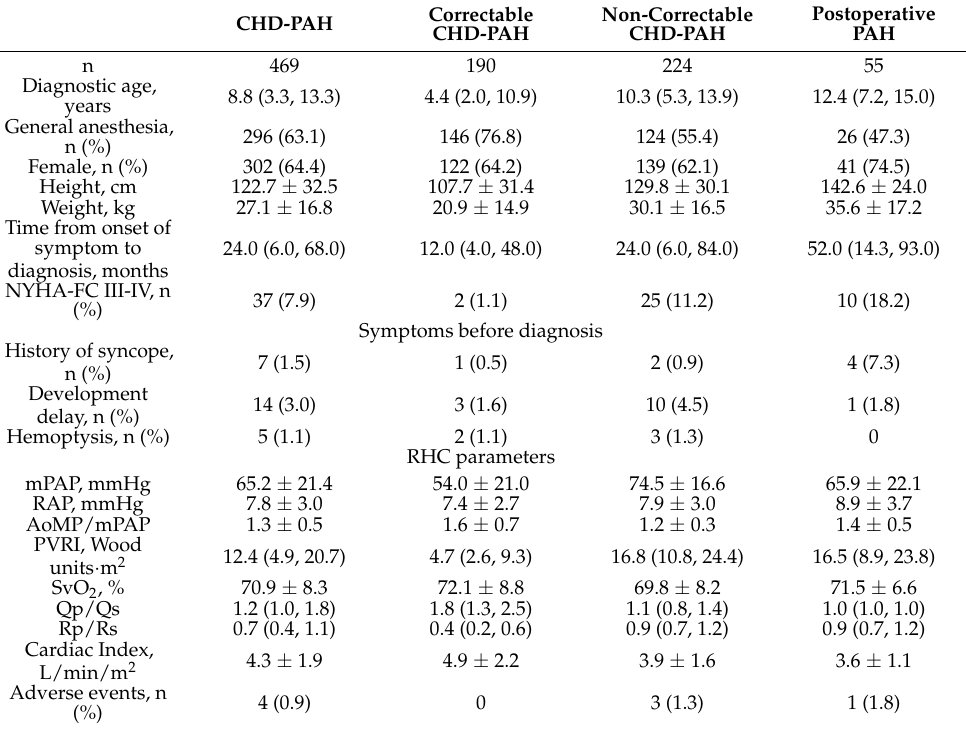
Table 1. Clinical characteristics and hemodynamics of patients with CHD-PAH.